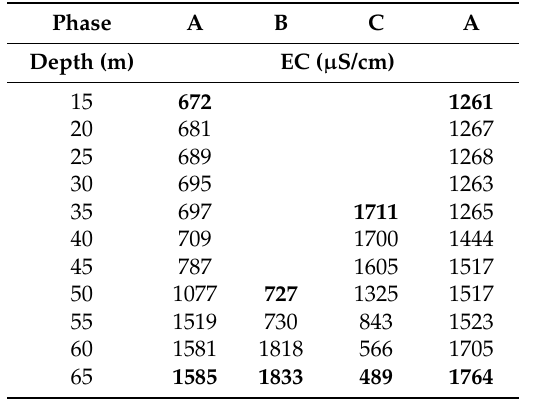
Table 3. Change in EC as a function of depth at PP-3 in the various